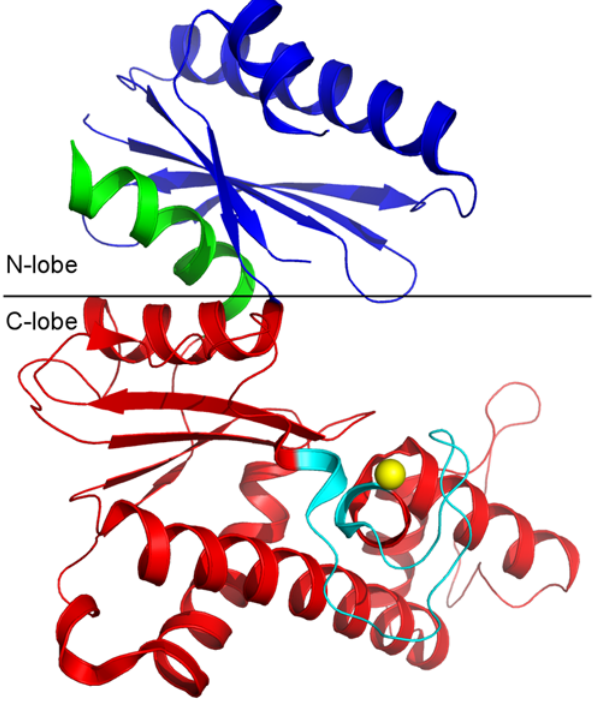
Figure 2. Overall structure of the kinase domain of GNE. The C- terminal helix (residues 700–717, in green) is embedded into the N-lobe subdomain. The ROK family signature zinc-binding motif (cyan) is located on top of two parallel helices of the C-lobe. Residues 475–498 in the N-lobe are missing in the electron density map and are presented by dotted line